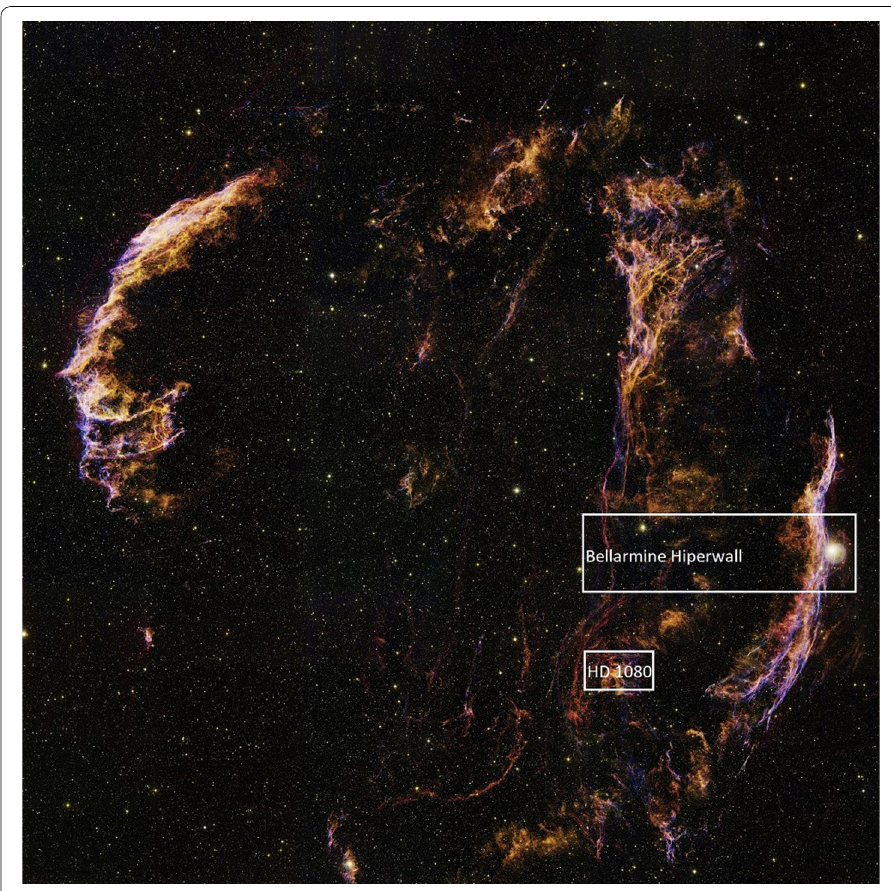
Fig. 4 The total viewing area of the 7680 × 2160 pixels (16.5 Megapixels) Hiperwall Display and a standard HD 1920 × 1080 (2 Megapixels) monitor superimposed (shown as white boxes) on top of a 24457 ×